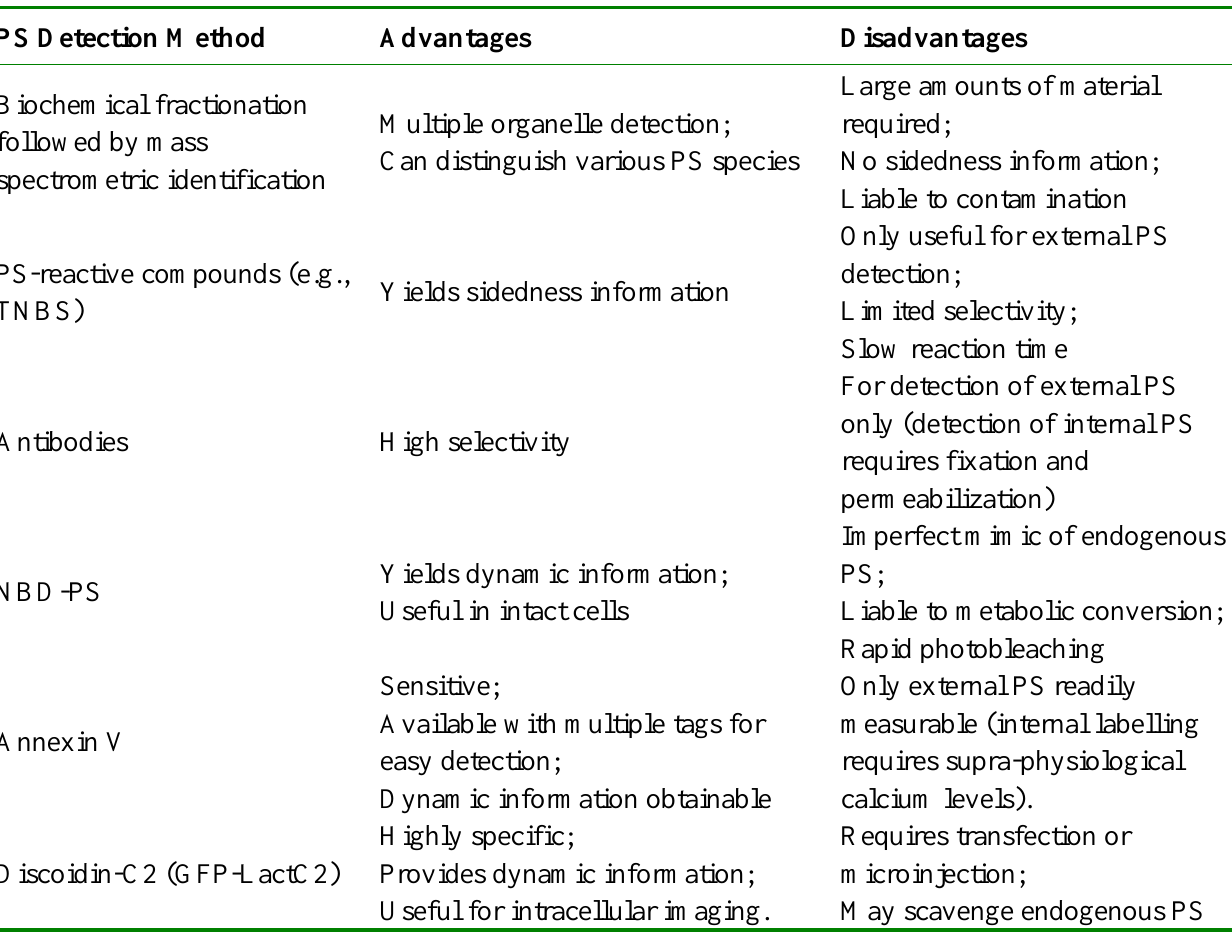
Table 1. Advantages and Disadvantages of PS detection